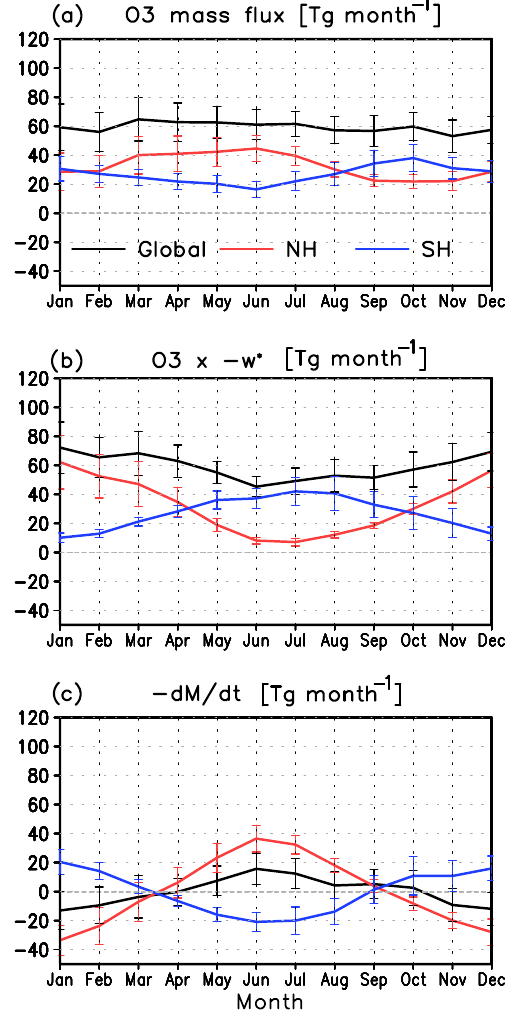
Figure 2. (a) Annual ozone mass flux and its 95% confidence inter- val (i.e., ± 2 σ , where σ is standard deviation) [Tgmonth − 1 ] from the stratosphere into the troposphere ( F out ) in the REF2000 sim- ulation integrated globally (black), over the Northern Hemisphere (red) and the Southern Hemisphere (blue). (b) Same as (a) but for F in (the product between the ozone concentration and the negative zonal mean residual vertical velocity w ∗ at 91hPa). (c) Same as (a) but for the negative monthly change in ozone mass of the LMS ( − d M/ d t ), also referred to as seasonal